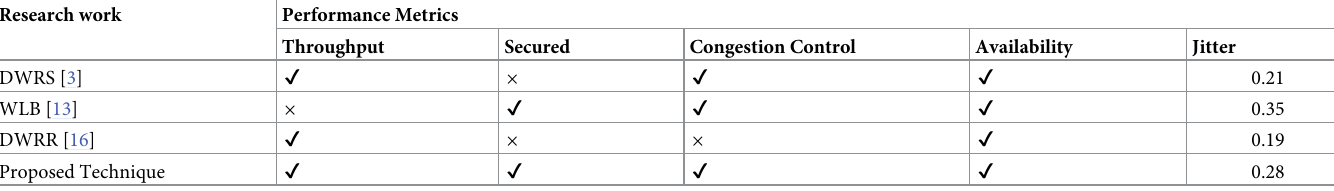
Table 4. Comparative analysis of related